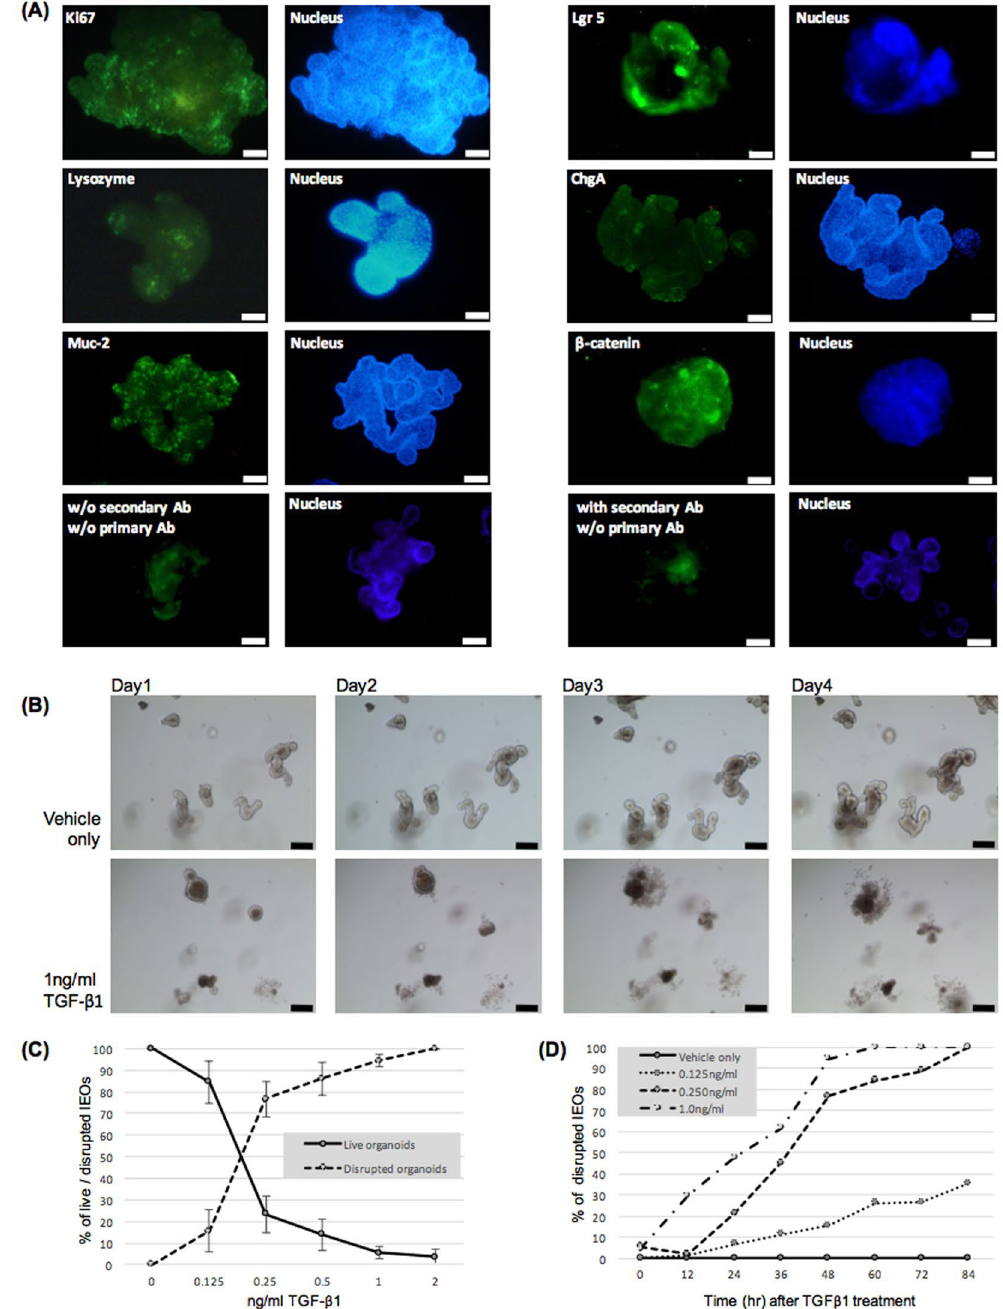
Figure 1. Disruption of IEOs by TGF- β 1 treatment. ( A ) Cellular components of IEOs were stained with various cell markers constituting the intestinal epithelium. Bars, 50 μ m. ( B ) Representative images showing IEOs treated with or without TGF- β . Bars, 100 μ m. ( C ) Concentration-dependency of the TGF- β 1-mediated IEO disruption. The number of live and disrupted organoids was counted by concentration after 48 hours TGF- β 1 treatment. ( D ) Time-dependency of the TGF- β 1-mediated IEO disruption. The number of live and disrupted organoids was counted by time after the treatment. Data are presented as the mean ± SEM; n = 3 samples per